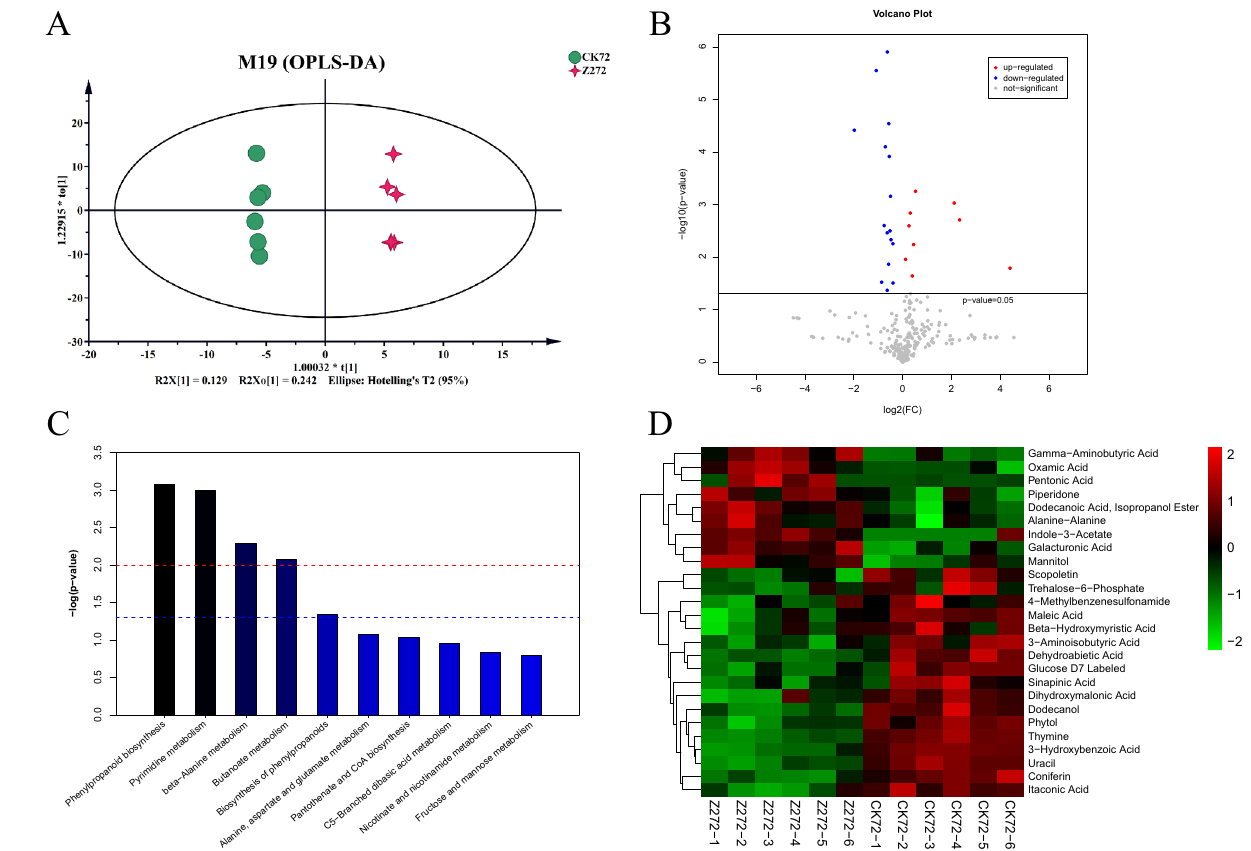
Figure 1. The changes of metabolites in B. napus between control (CK72) and HT-COS (Z272) treatments. ( A ) The orthogonal partial least squares discriminant analysis in metabolite contents. ( B ) The volcano plot of significantly differentiated metabolite contents. ( C ) The gene functional enrichment of significantly up-regulated metabolites under the DA treatment. ( D ) The heat map of metabolites